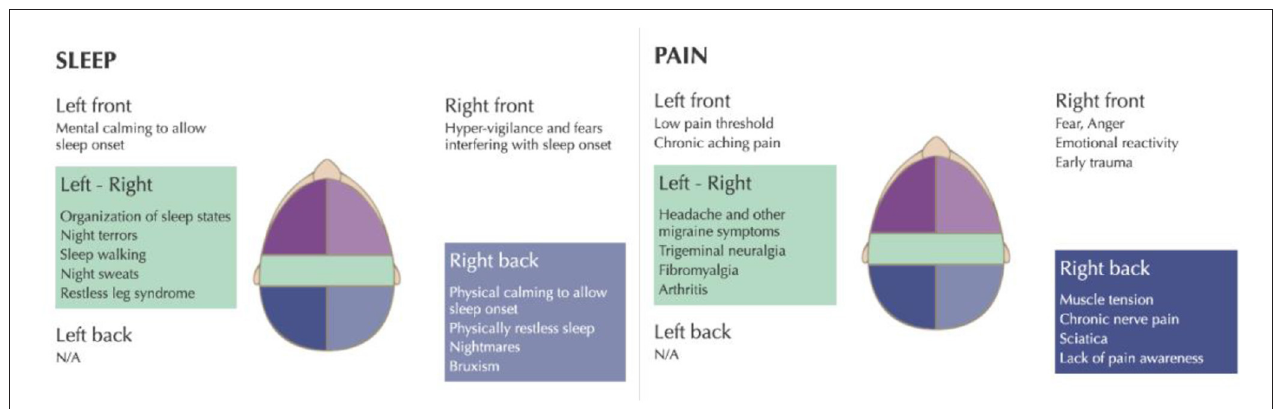
FIGURE 2 | infra-low neurofeedback frequency training protocols for insomnia and chronic pain. Taken with permission from Othmer (2019).